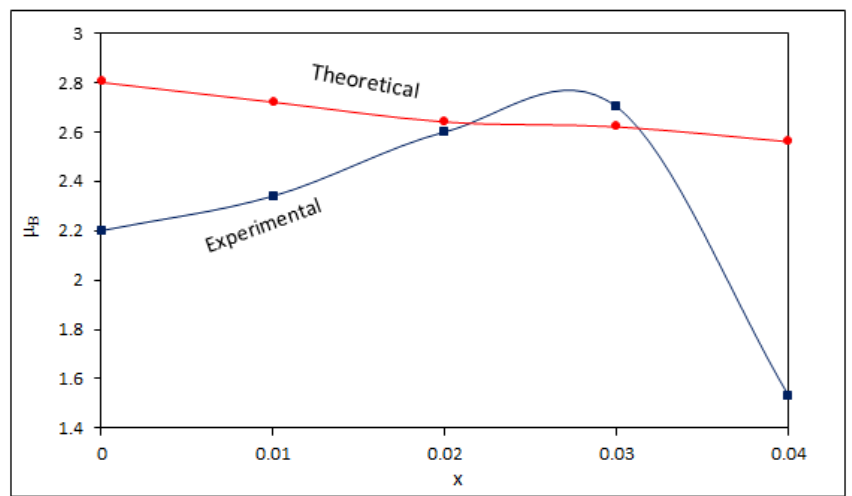
Fig. 12: The variation of magnetic moment with Li